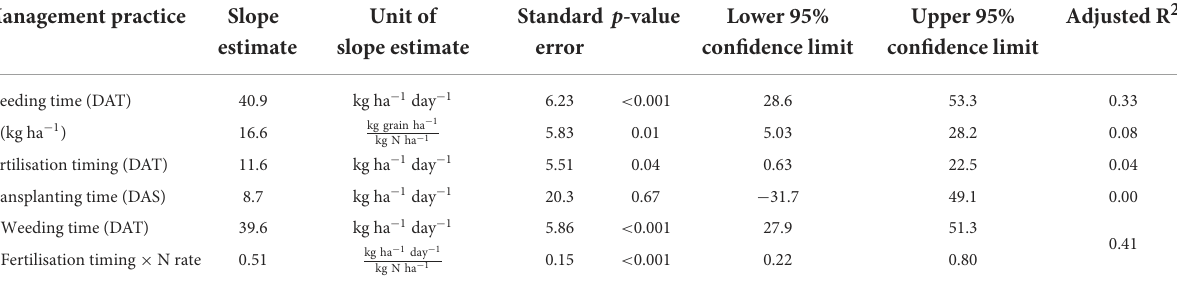
TABLE 2 Slopes of linear regression lines relating change in grain yield on farmers’ fields and change in management practices of farmers after participation in joint experimentation, Doho rice irrigation scheme, Butaleja District, Uganda, 2021. Management practice Slope Unit of Standard Lower 95% Upper 95% Adjusted R 2 estimate slope estimate confidence limit confidence limit